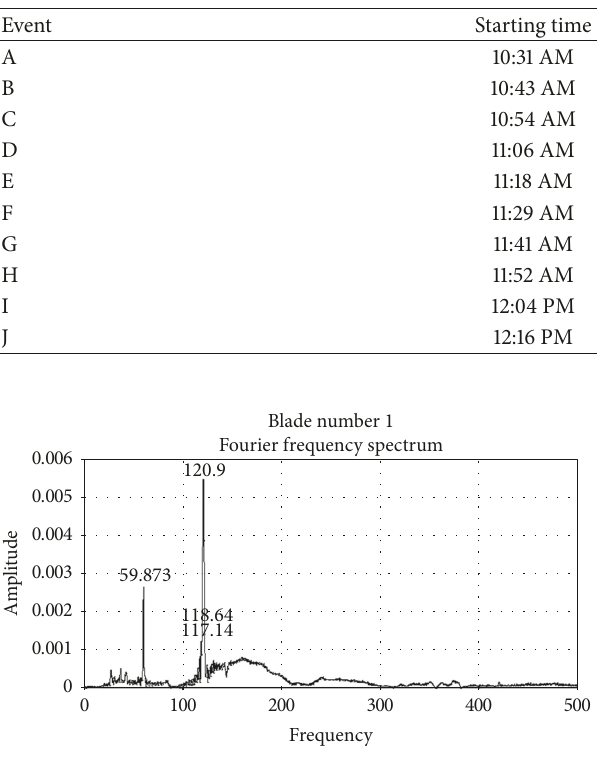
Figure 3: Fourier spectrum, impact test.